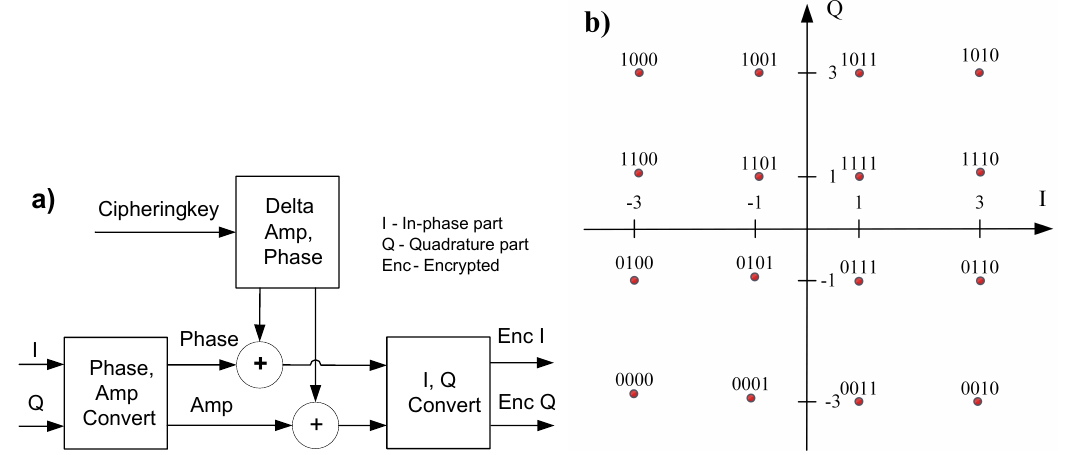
Figure 2. ( a ) Conventional physical layer encryption; ( b ) constellation for 16-QAM